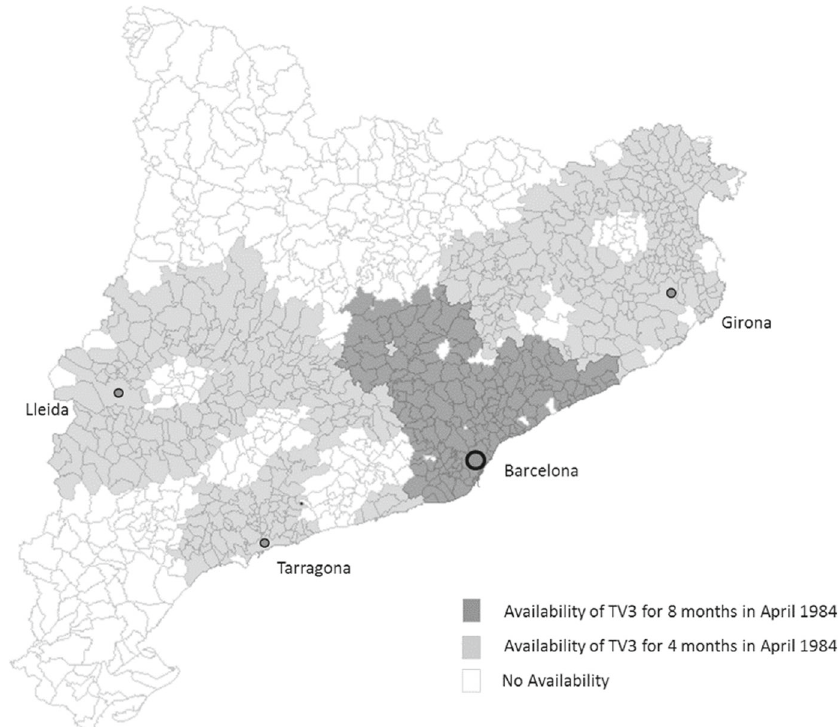
Fig. 3 Availability of TV3 by duration in Catalonia in April